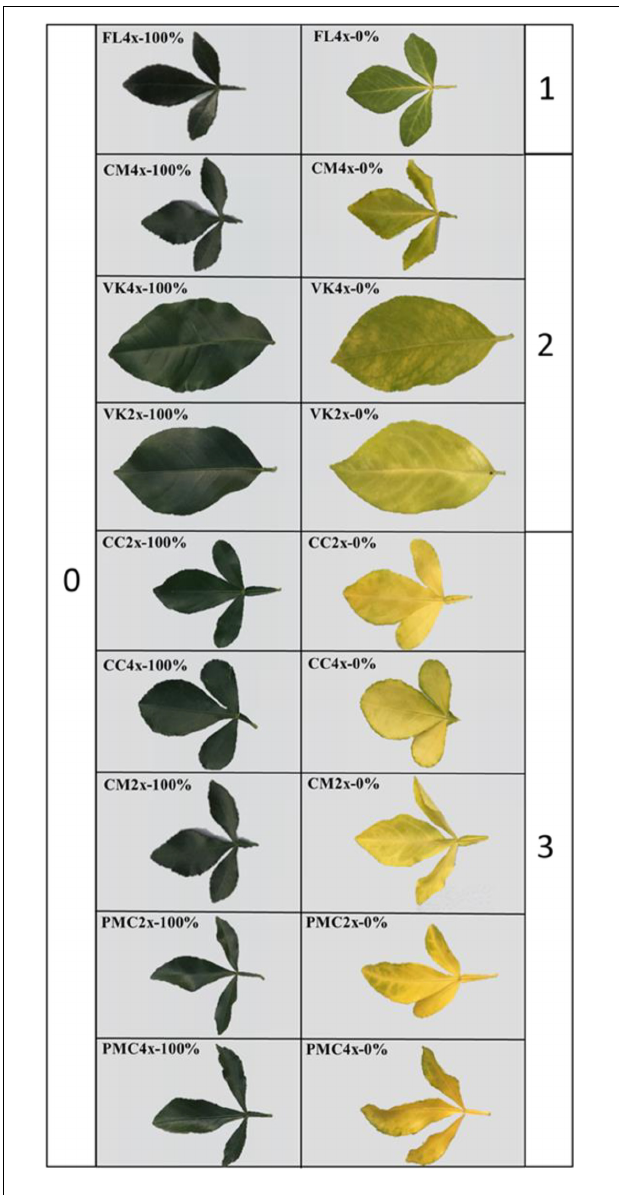
FIGURE 1 | Leaf damages after 210 days of total nutrient deficiency on the nine genotypes (0%) compared to controls (100%). Genotypes are ranked based on the leaf symptoms from the unaffected (0) to the more affected